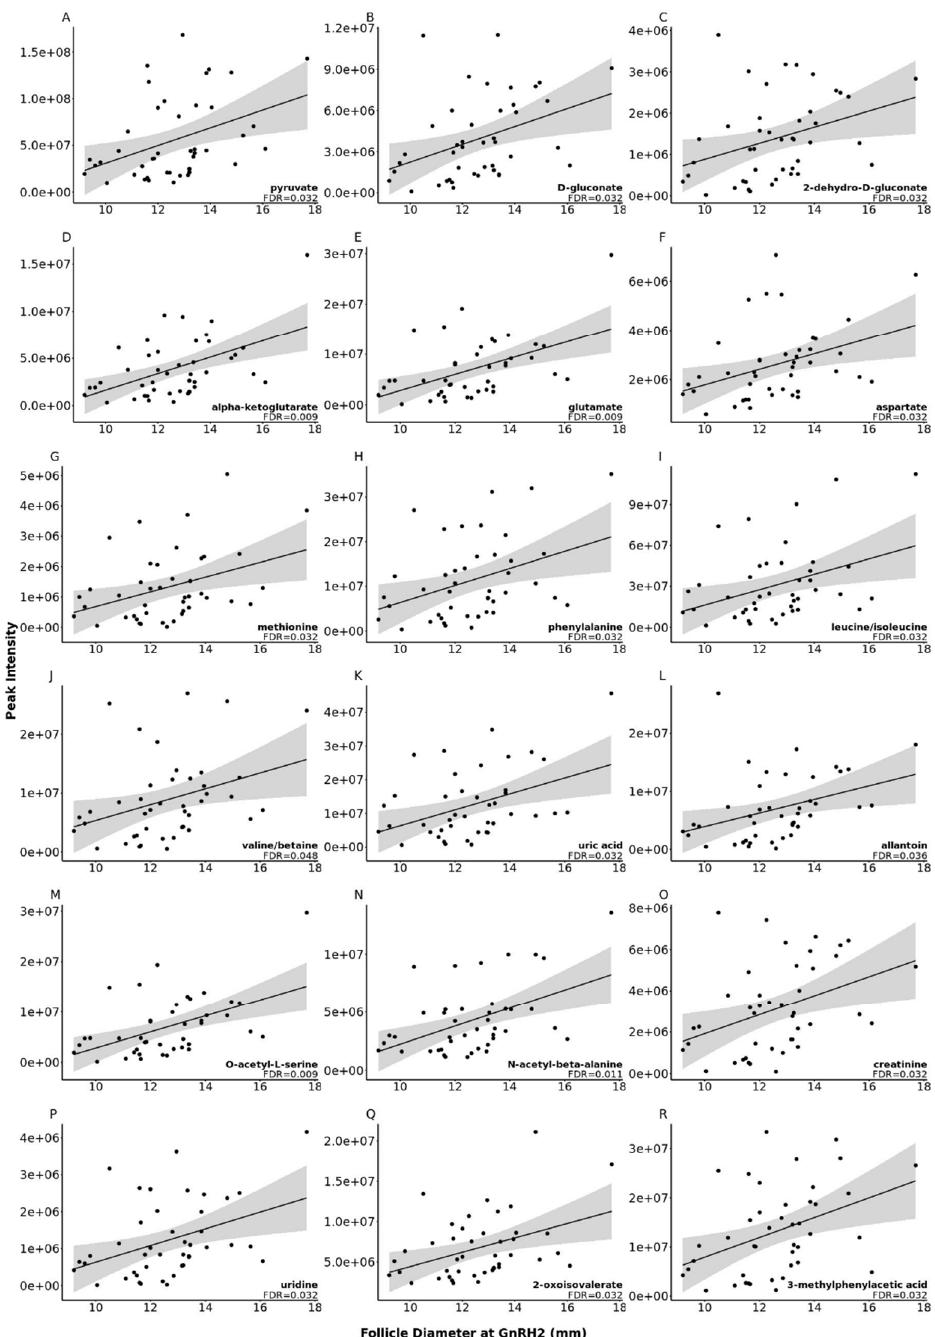
Figure 3. Scatter plots of the correlation between metabolite peak area and follicle diameter at the time of gonadotropin releasing hormone (GnRH2) administration to induce the pre-ovulatory gonadotropin surge for 18 metabolites, depicted in panels ( A – R ), that were significantly correlated with increasing follicle diameter at GnRH2 (FDR < 0.05).